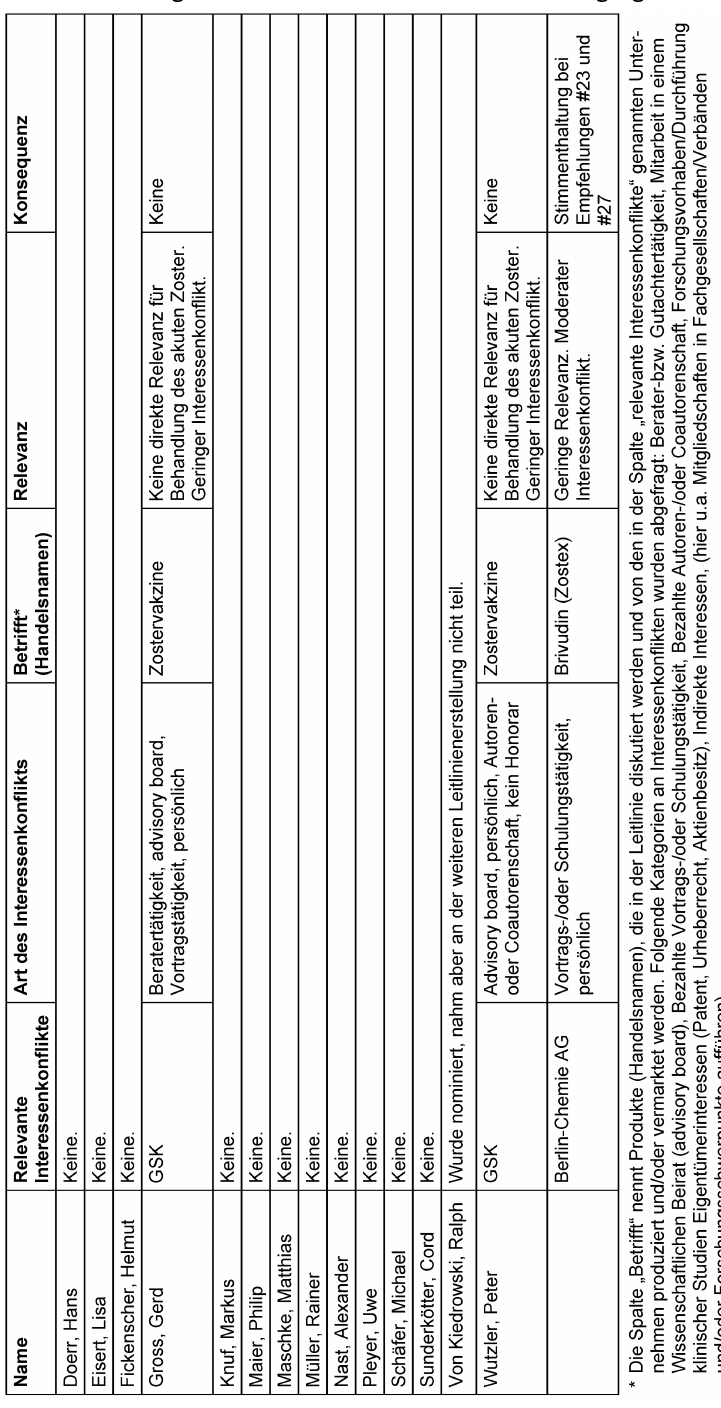
epithelialer Beteiligung sollte auf die topische Steroidgabe verzichtet werden, da es sonst zu einer Dissemination der epithelialen Läsionen kommen kann. Bei Zoster oticus fehlt Evidenz aus Studien zur Empfeh- lung einer spezifischen topischen